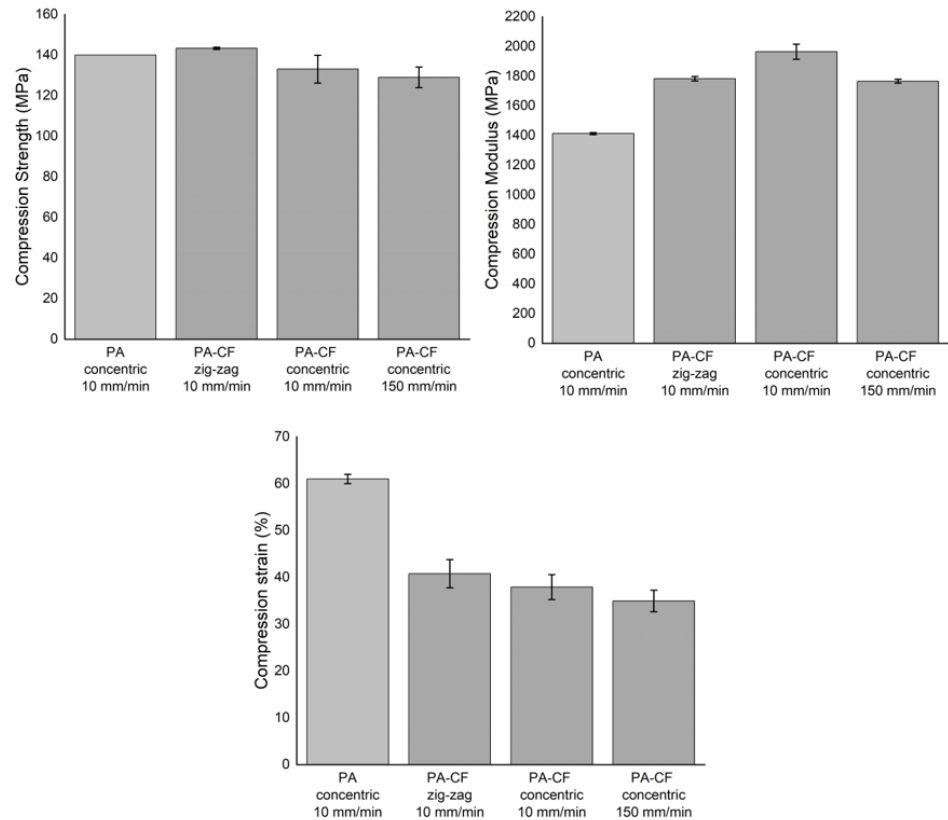
Figure 8. Compression properties: compression strength, compression modulus, and compression strain.